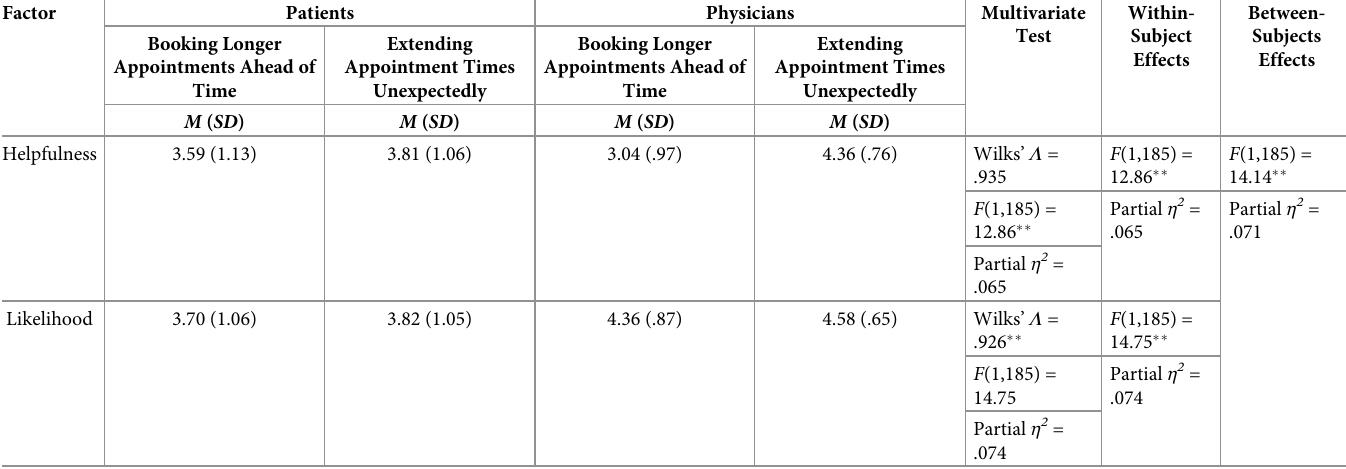
Table 4. Repeated measures ANOVA results comparing patients’ and physicians’ responses for booking longer appointments ahead of time and extending appoint- ment times